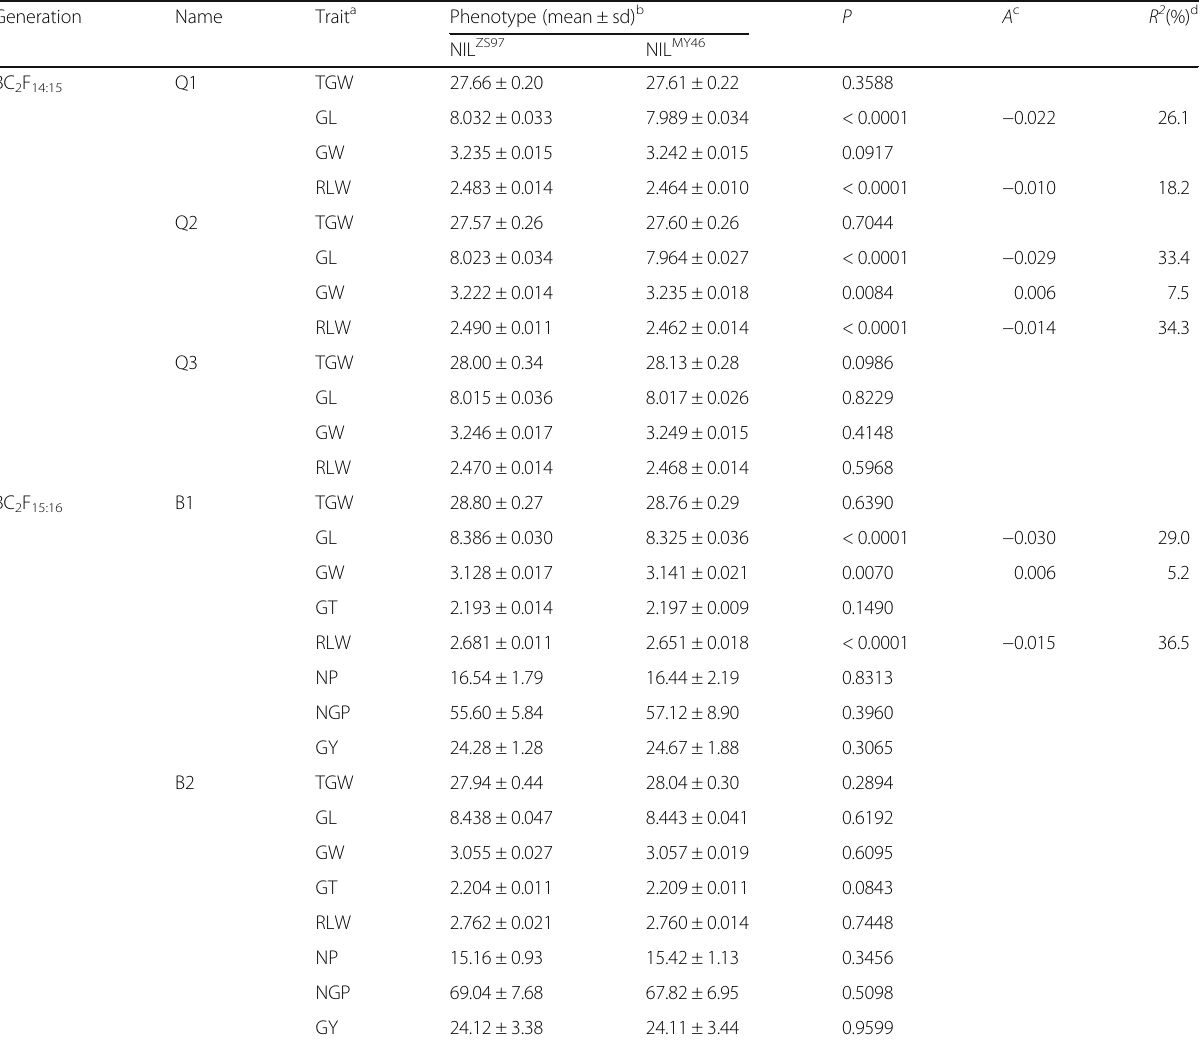
Table 4 Fine mapping of qGS1-35.2 using five sets of near isogenic lines in BC 2 F 14:15 and BC 2 F 15:16